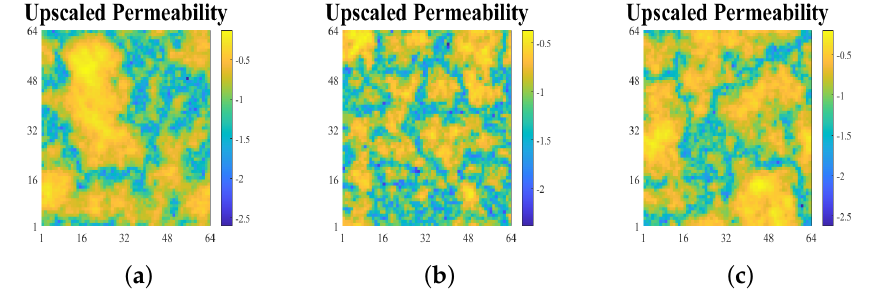
Figure 9. ( a ) Sample output data of upscaled permeability field “a” on 64 × 64 grid generated using numerical upscaling and used in training the neural network. ( b ) Sample output data of upscaled permeability field “b” on 64 × 64 grid generated using numerical upscaling and used in training the neural network. ( c ) Sample output data of upscaled permeability field “c” on 64 × 64 grid generated using numerical upscaling and used in training the neural